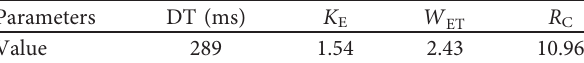
Table 3: The bursting liability parameters of No. 4 coal seam.